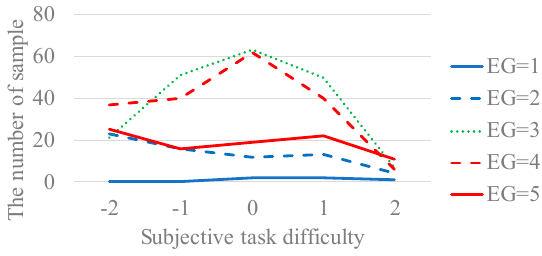
Figure 4. The sample size of engagement (EG) and subjective task difficulty.